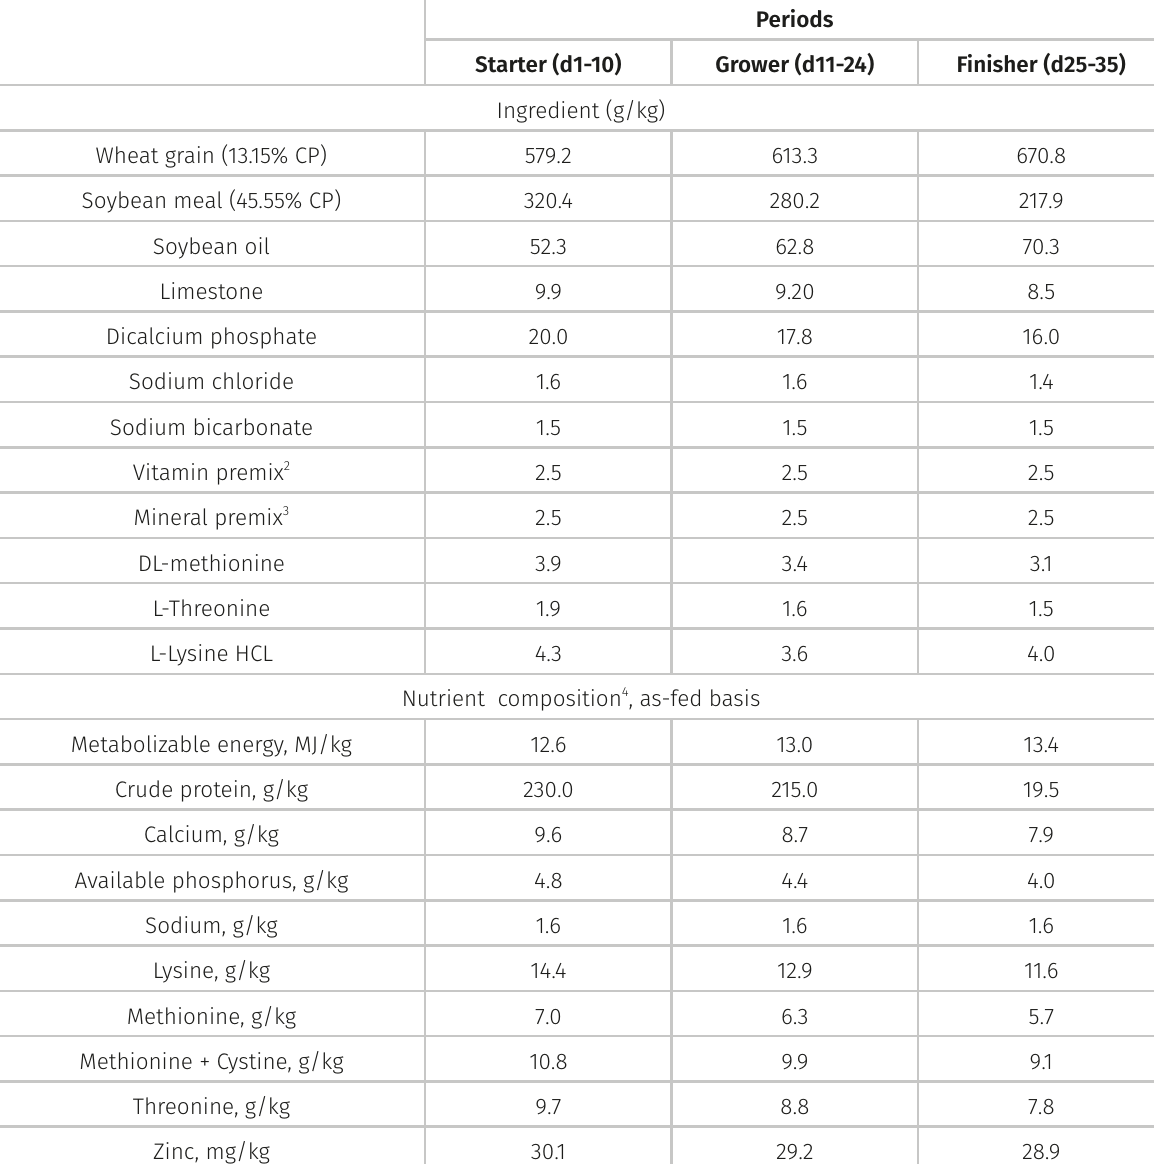
Table I. Feed ingredients and composition of the basal wheat-soy diets 1